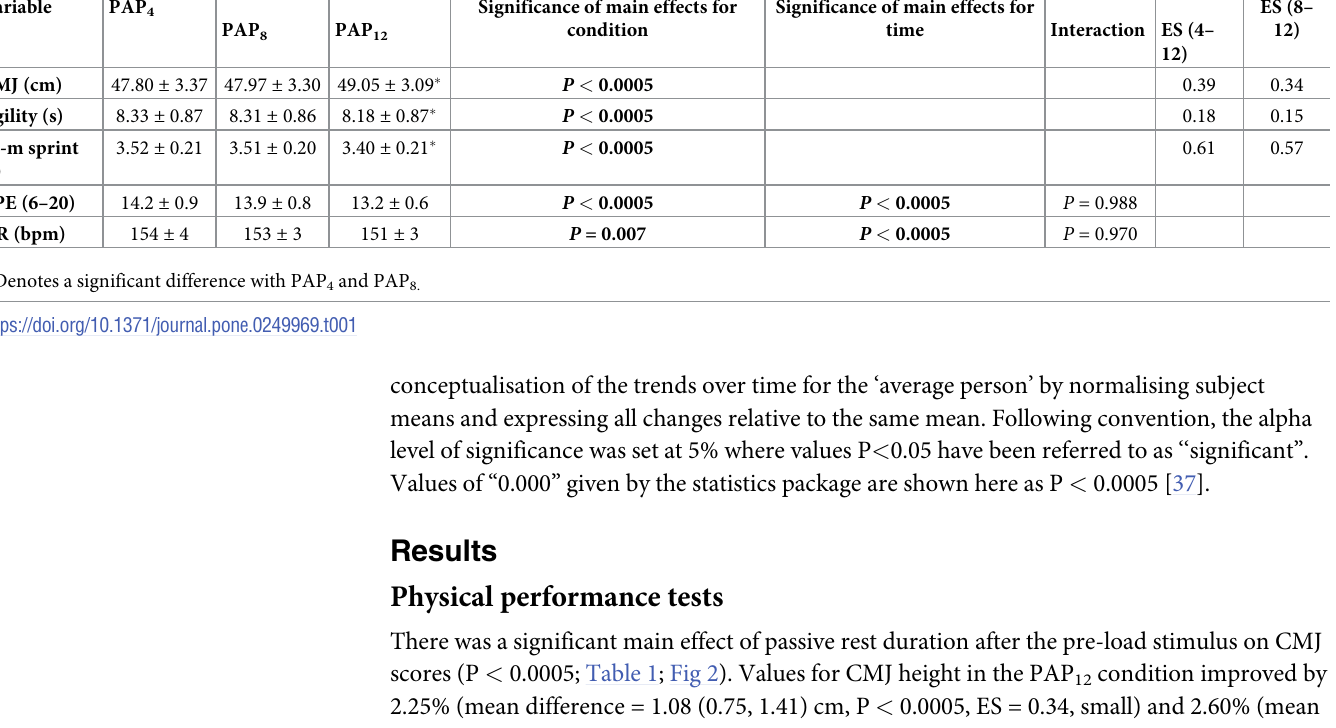
Table 1. Mean ( ± SD) values for physical performance variables and subjective measures in the three PAP conditions. Statistical significance ( P < 0.05) is indicated in bold. The magnitude of the ES is classified as trivial ( � 0.2), small ( > 0.2–0.6) and moderate ( > 0.6–1.2).